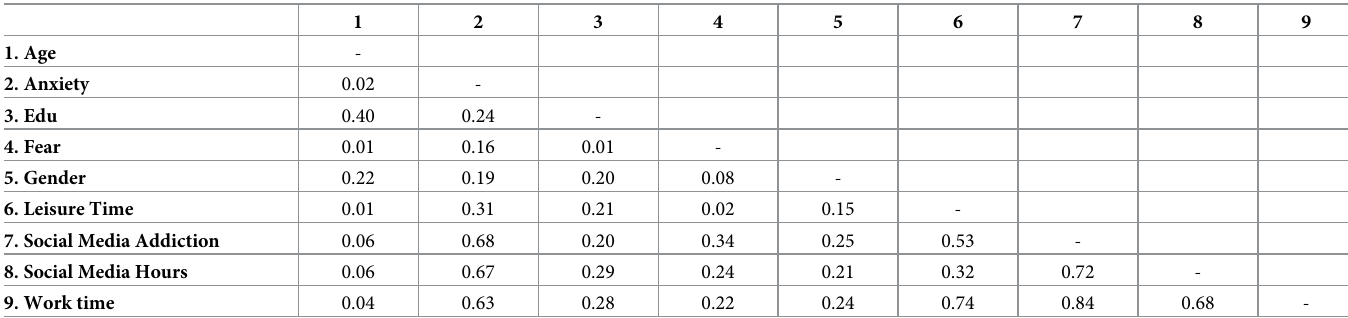
Table 4. Heterotrait-Monotrait Ratio